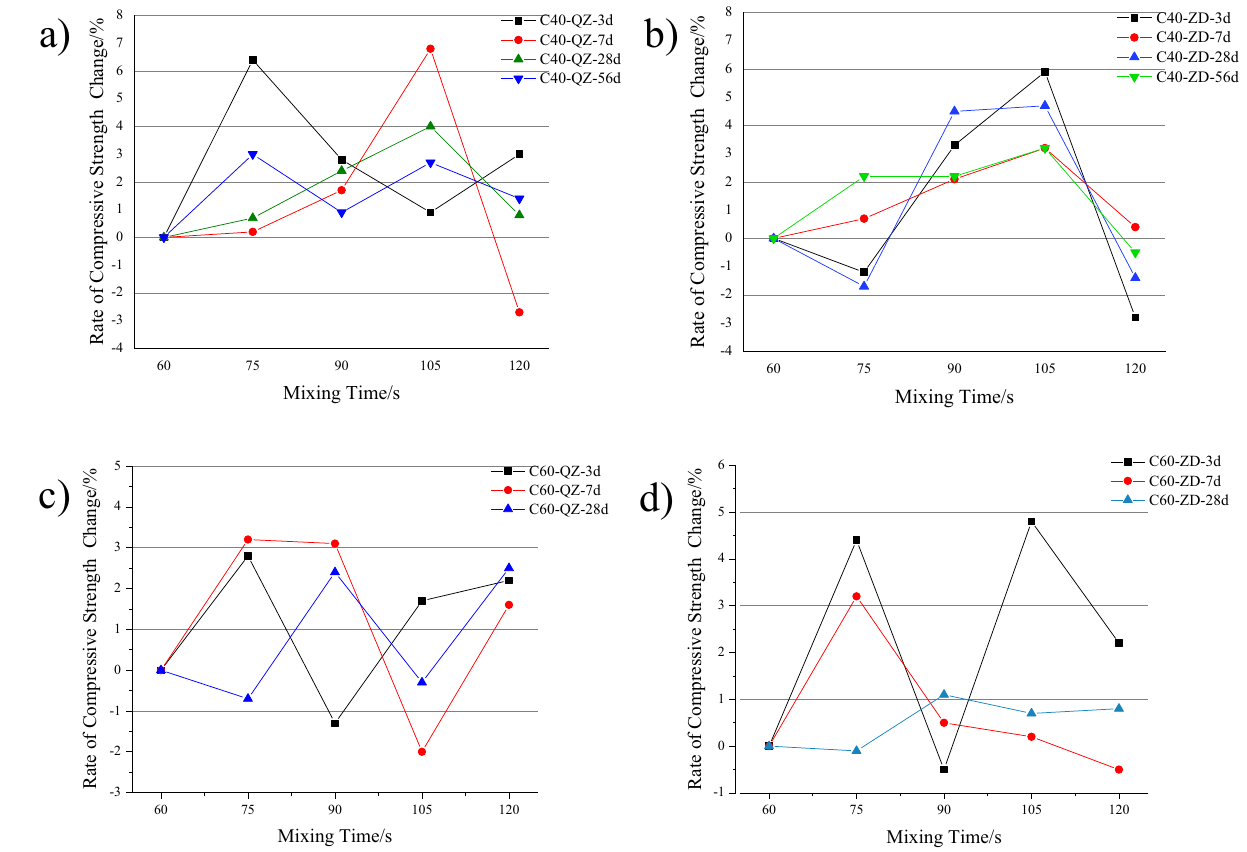
Figure 7: The change rate of concrete strength. ( a ) Forced mixing C40 concrete strength change rate. ( b ) Vibrating mixing C40 concrete strength change rate. ( c ) Forced mixing C60 concrete strength change rate. ( d ) Vibration mixing C60 concrete strength change